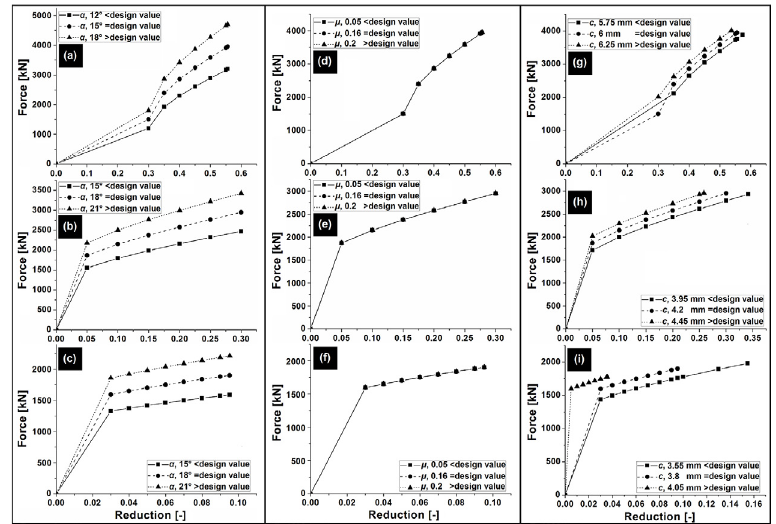
Figure 7. Graphical showing of ironing punch force influenced by, (a-c) semi die angle ( α ); (d-f) interfacial coefficient of friction ( μ ); (g-i) die-punch clearance ( c ), in 1 st draw, 2 nd draw and 3 rd draw respectively in each